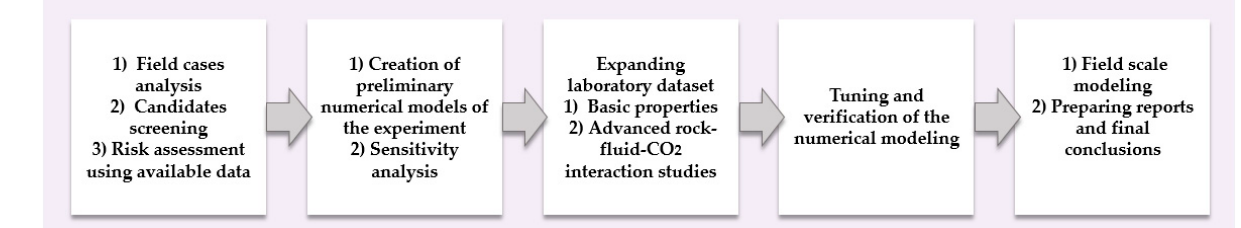
Figure 9. Workflow of the CO 2 storage implementation in DOGR.